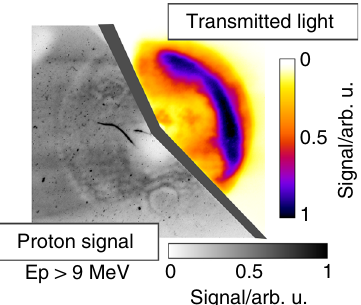
Fig. 4 Example measurement of transmitted laser light and proton beam pro fi le on the same shot. Protons with energies higher than 9 MeV are